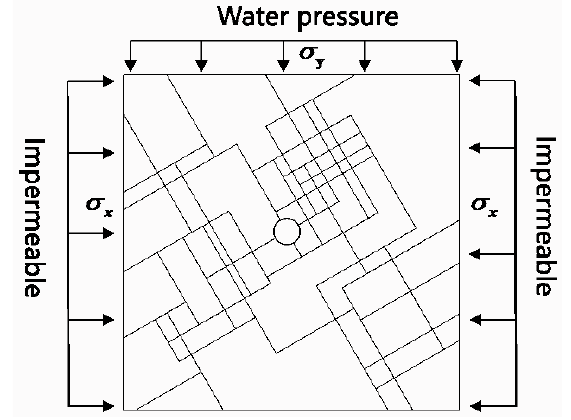
Figure 19. Two-dimensional model of fractured rock mass.